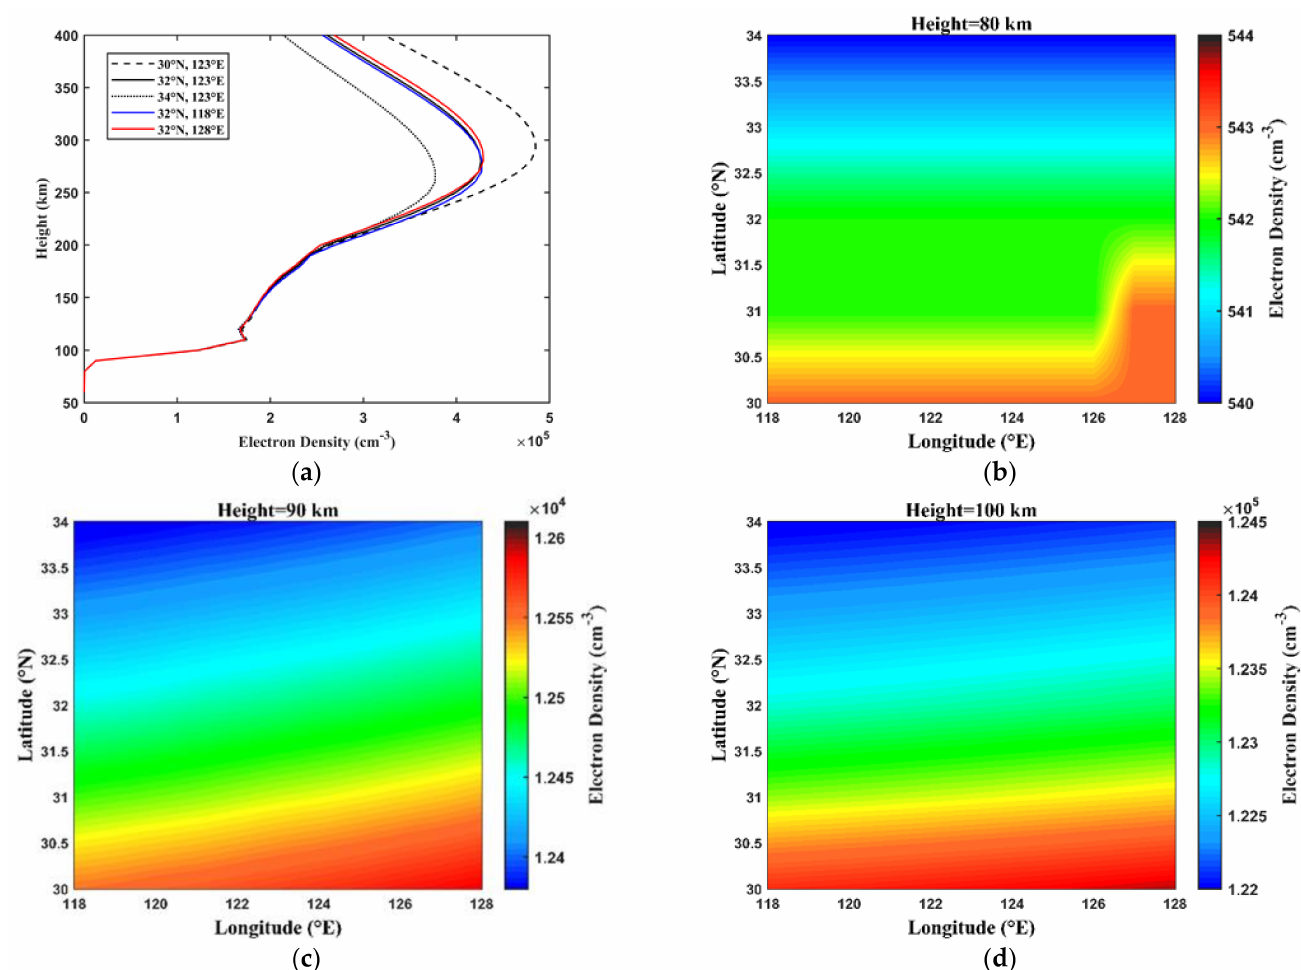
Figure 3. Distribution of electron density with height, latitude, and longitude. ( a ) Distribution of electron density at five locations by height. ( b – d ) show the distribution of electron density at 80, 90, and 100 km height with latitude and longitude,